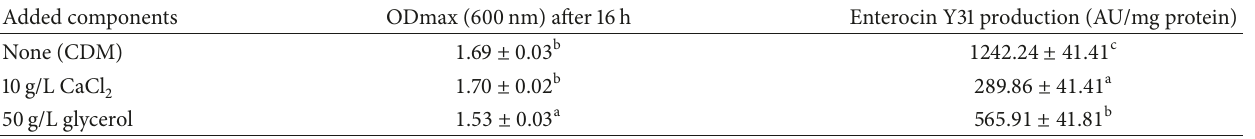
Table 2: Effects of CaCl 2 and glycerol on the growth of Enterococcus faecium Y31 and Enterocin Y31 production.